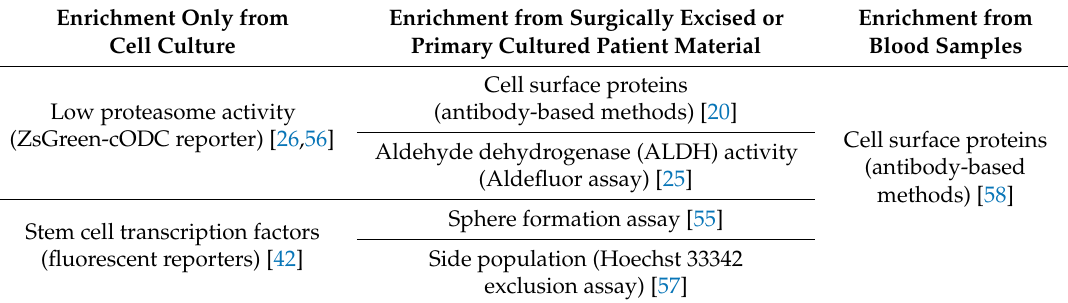
Table 2. Applications of CSC enrichment methods in